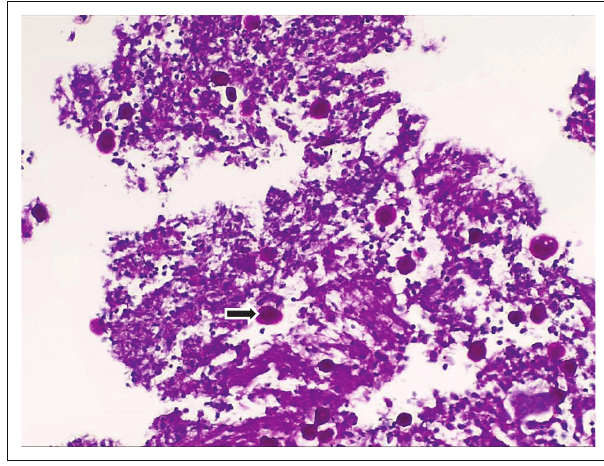
Source : Pathological slide of actual patient captured by S. Mewa Kinoo FIGURE 4: Multiple round to oval amoebic trophozoites (black arrow) measuring 6 nm – 40 nm, resembling macrophages, are seen lying freely within debris.